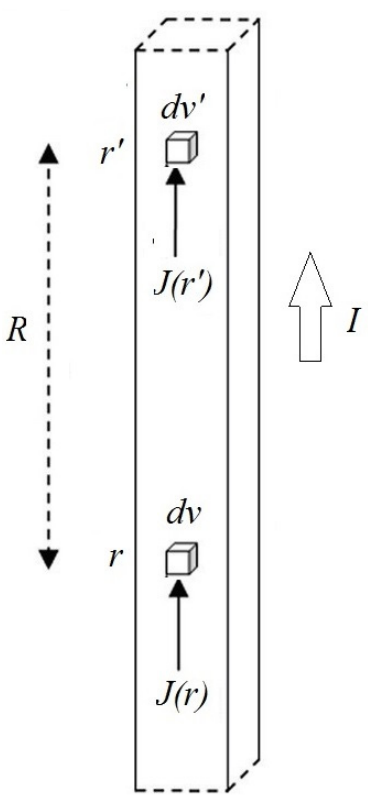
Figure 1. Conductor schematization for inductance calculation.